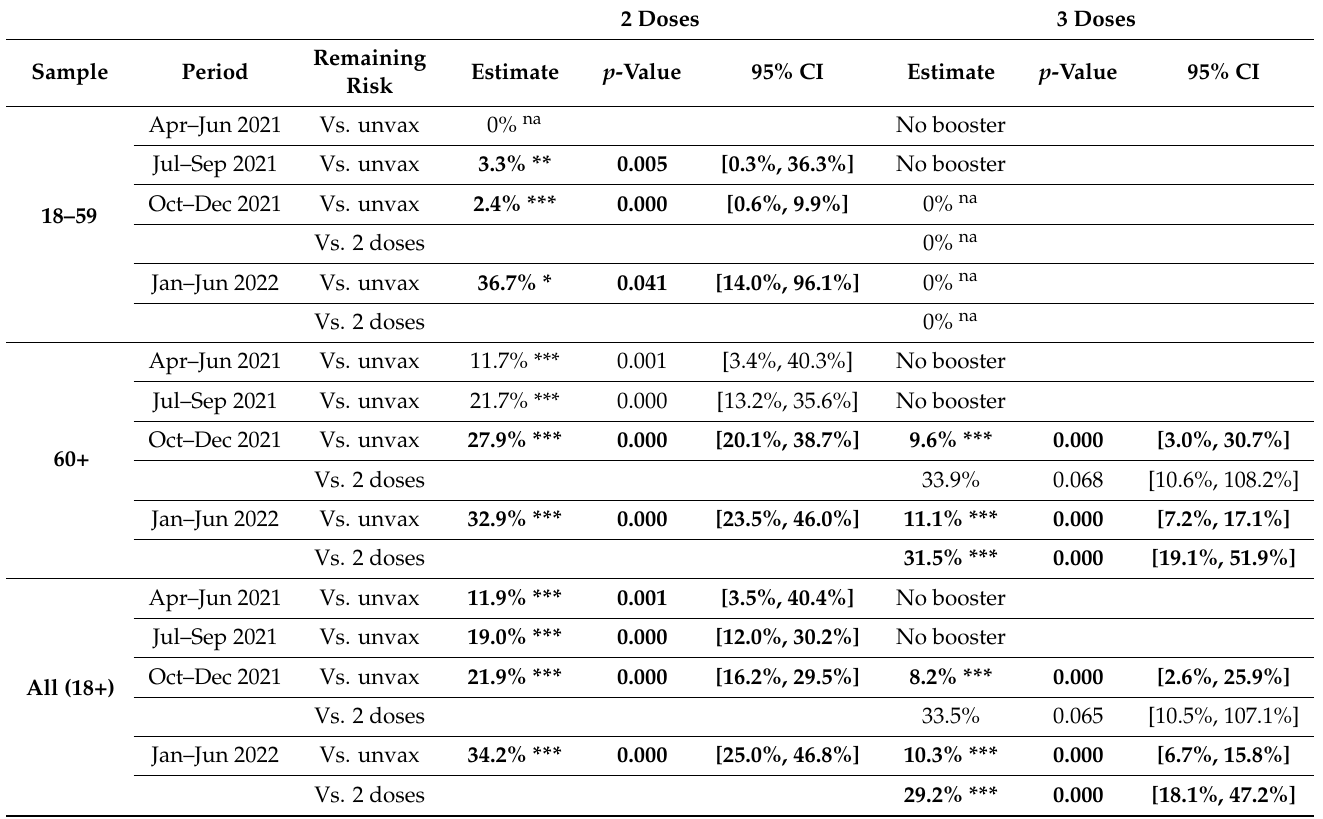
Table 3. COVID-19 Relative Mortality Risk (RMR) Calculated Using a Multivariate Logit Model. 2 Doses 3